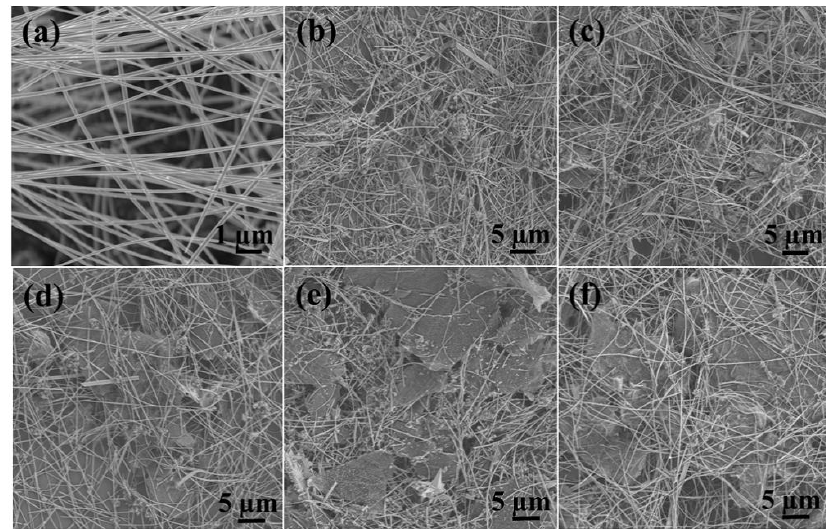
Figure 4. ( a ) SEM image of PPy-coated Cu 2 O nanowires, hydrothermally prepared at 120 °C, and as-prepared rGO/PPy/Cu 2 O nanocomposites after high-temperature thermal reduction. The GO to PPy/Cu 2 O mass ratio is ( b ) 0.08, ( c ) 0.1, ( d ) 0.12, ( e ) 0.15, and ( f ) 0.20.